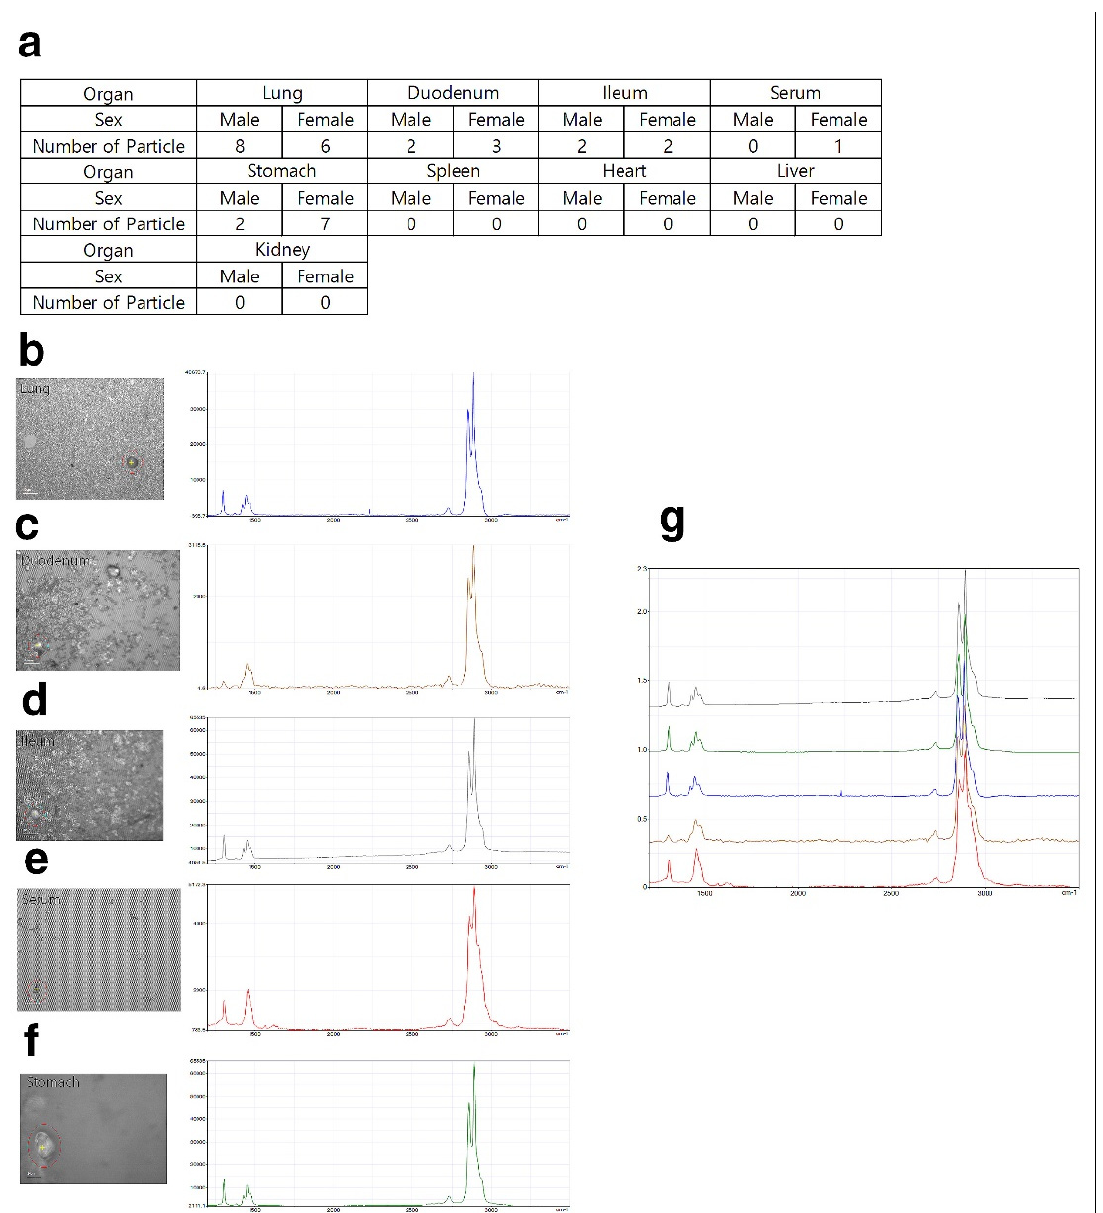
Figure 6. Quantitative evaluation of polyethylene microplastics. ( a ) Number of detected PE microplastic particles in samples from the 2000 mg/kg group. ( b – f ) PE microplastics (red circle) detected in lung, duodenum, ileum, serum, and stomach by Raman spectroscopy and wave number of polyethylene microplastics. ( g ) One plot of wave number of ( b – f ).